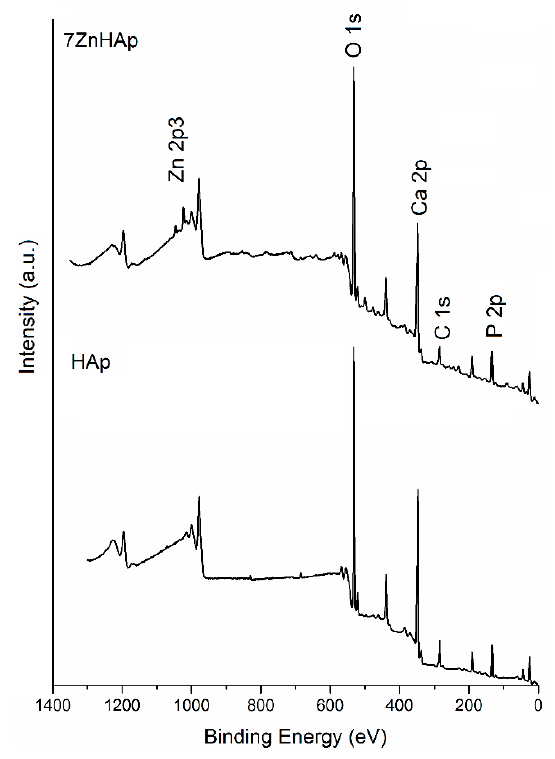
Figure 2. General XPS spectra of HAp and 7HApZn powders.